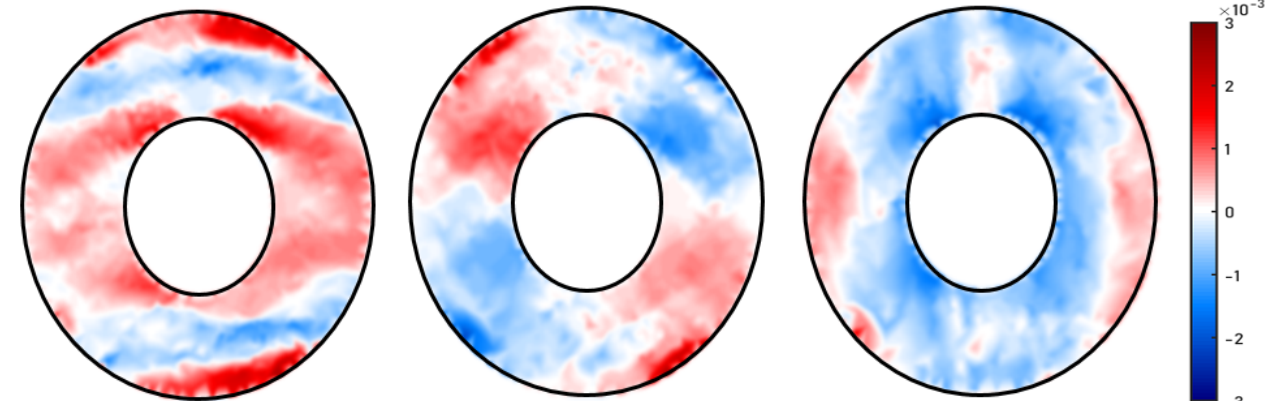
Figure 15. The reconstructed full-field two-dimensional strain components ( ε xx , ε xy , and ε yy ) with RBF .